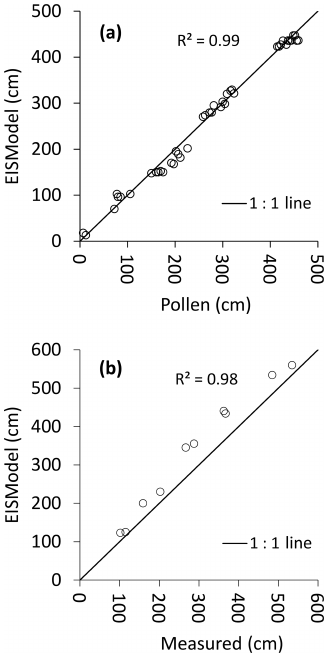
Figure 3. Mass balance modeled by EISModel compared with (a) pollen dating in the period from 2005 to 2009 and (b) mass balance measurements in the validation period from 2009 to